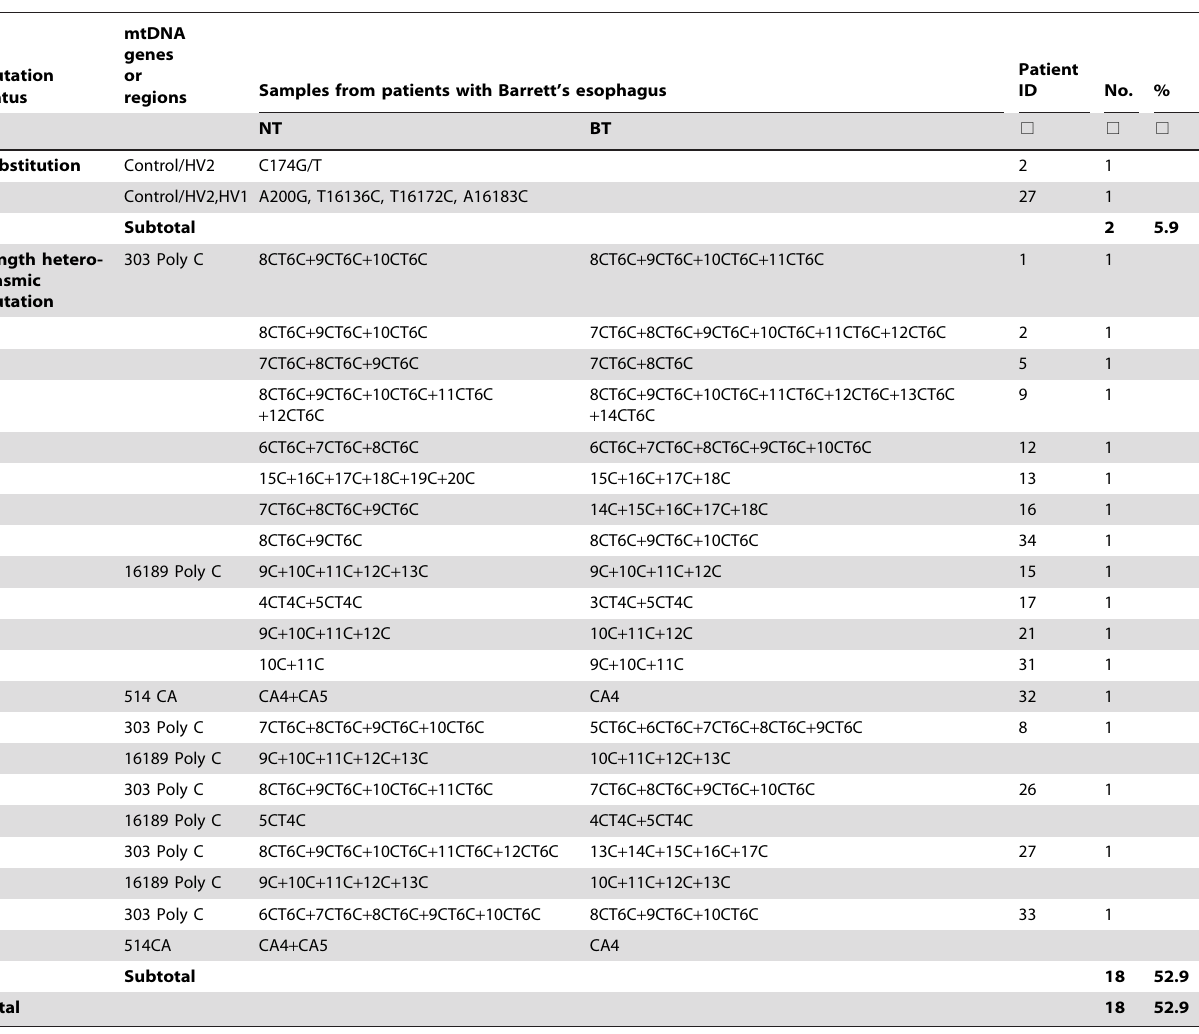
Table 1. mtDNA substitution and length heteroplasmic mutations in Barrett’s metaplasia tissue (BT) and adjacent normal mucosal tissue